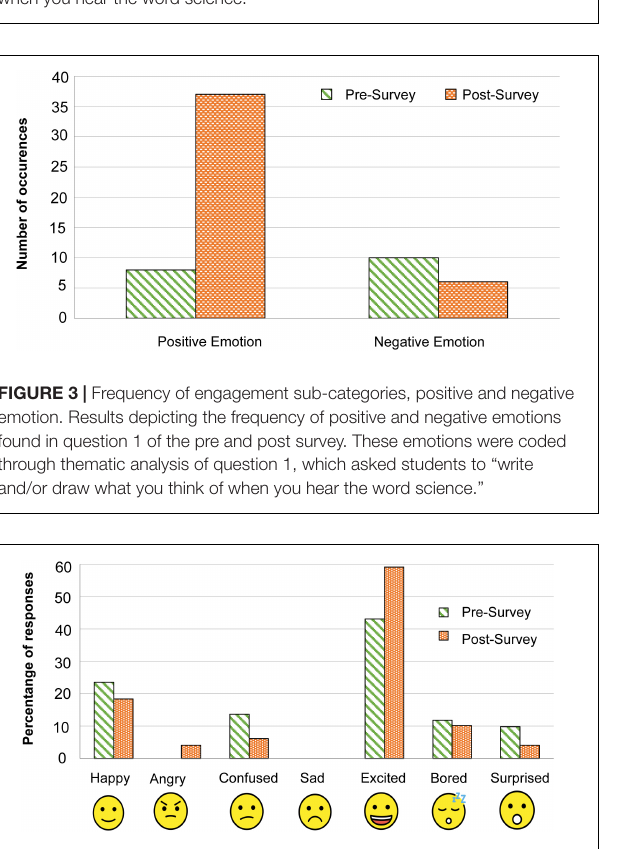
FIGURE 4 | Emoji selection pre to post survey. Results depict the percentage of frequency that each emoji was selected during pre and post surveys. Students were asked to select an emoji describing how science made them feel. Total number of occurrences of each emoji was divided by the total amount of emoji selections to determine percentage out of 100%. Pre survey had a total of 51 emojis selected, and post survey had 49. All emojis designed by